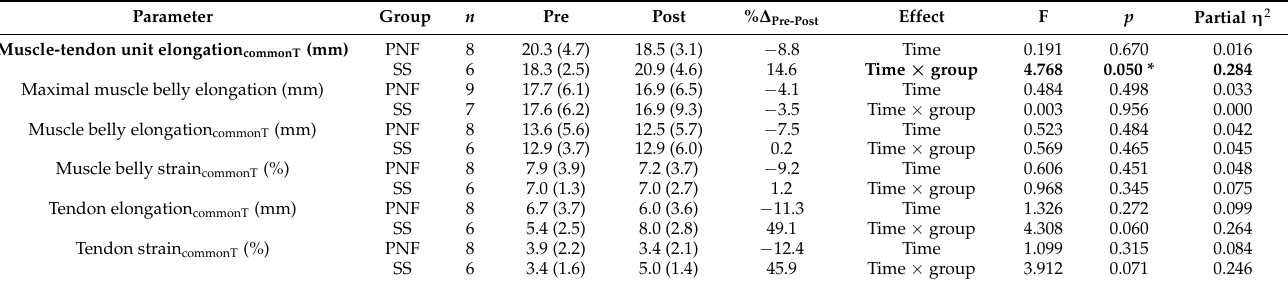
Table 3. Gastrocnemius muscle-tendon unit length, muscle belly length, and Achilles tendon length changes, as well as strain values measured during dorsiflexion rotations before (pre) and after (post) both acute proprioceptive neuromuscular facilitation (PNF) stretching and acute static stretching (SS) in children with spastic cerebral palsy. Data are presented as mean